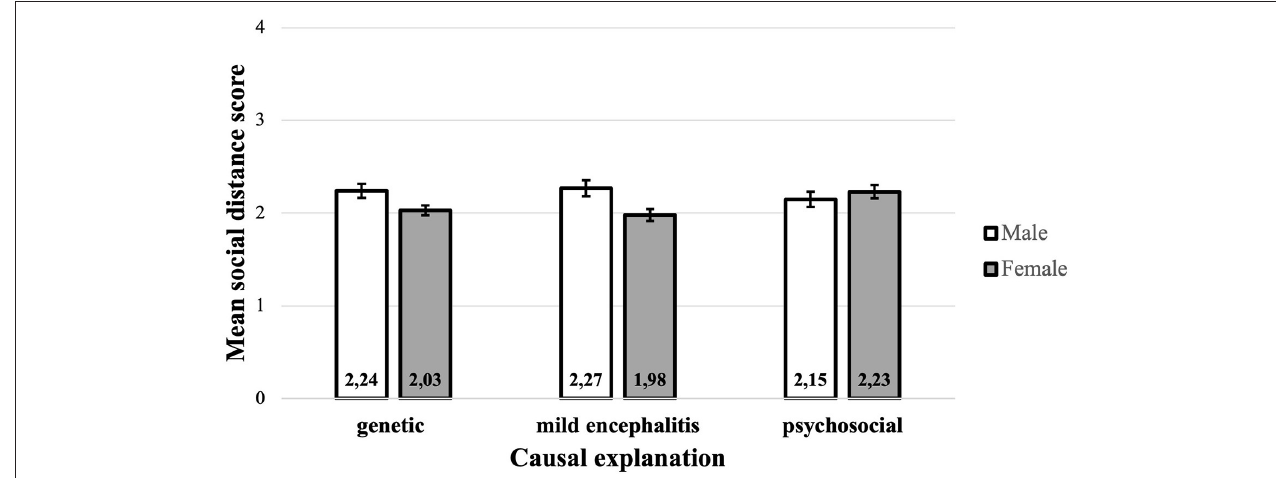
FIGURE 3 | Interaction between gender and causal